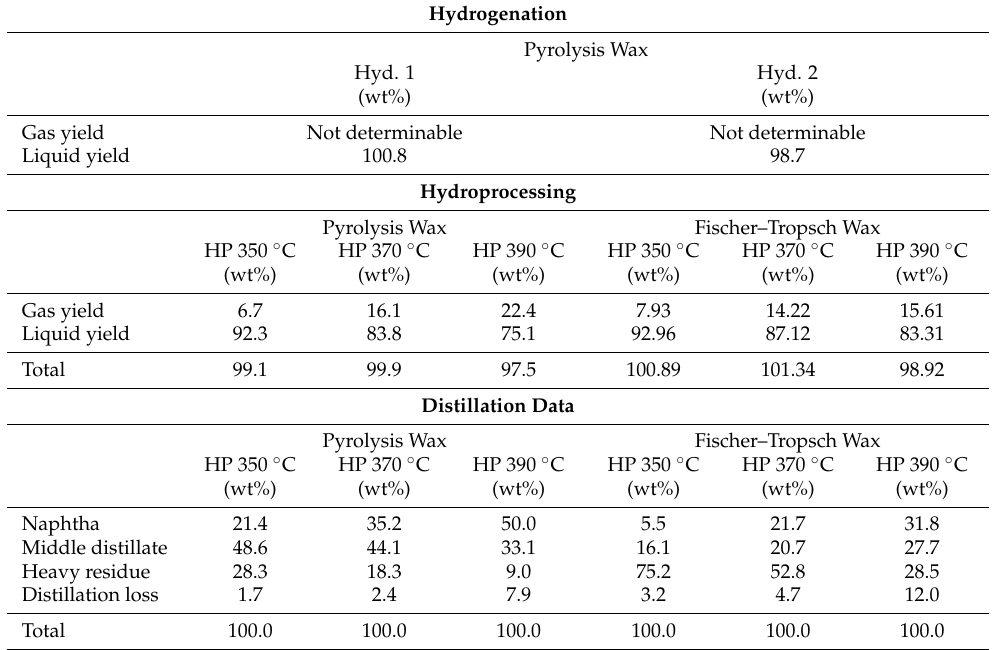
Table A1. Individual Mass